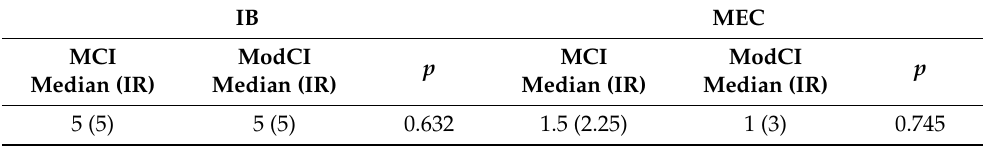
Table 4. Comparison of the improvement of patients with mild and moderate dementia in